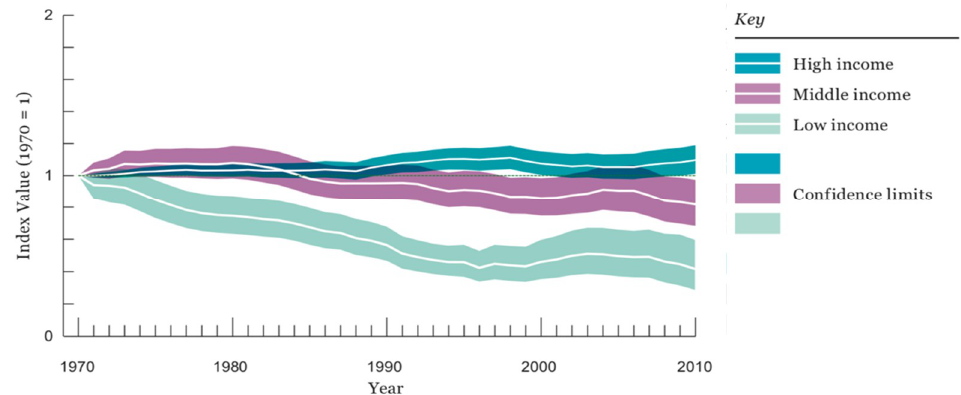
Figure 5. Inequality in the Living Planet Index, 1961–2010. LPI and World Bank country income groups (2013). Source: WWF—World Wide Fund for Nature (2014) Living Planet Report © 2014 WWF—All rights reserved.